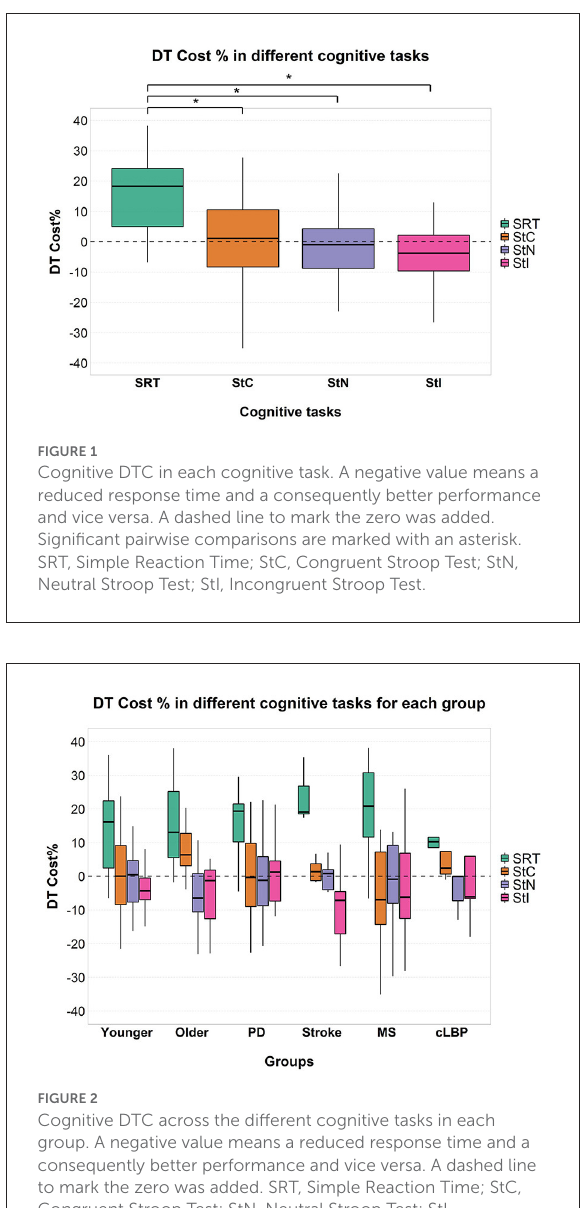
“group” [F (5, 85) = 3.022; p = 0.015; η 2 p = 0.151]. A significant effect of factor “group” was found for StC [F (5, 70) = 10.626; p < 0.001; η 2 = 0.432], StN [F = 10.663; p < 0.001; η 2 = (5, 68) p p 0.439] and StI [F (5, 71) = 15.337; p < 0.001; η 2 p = 0.519].